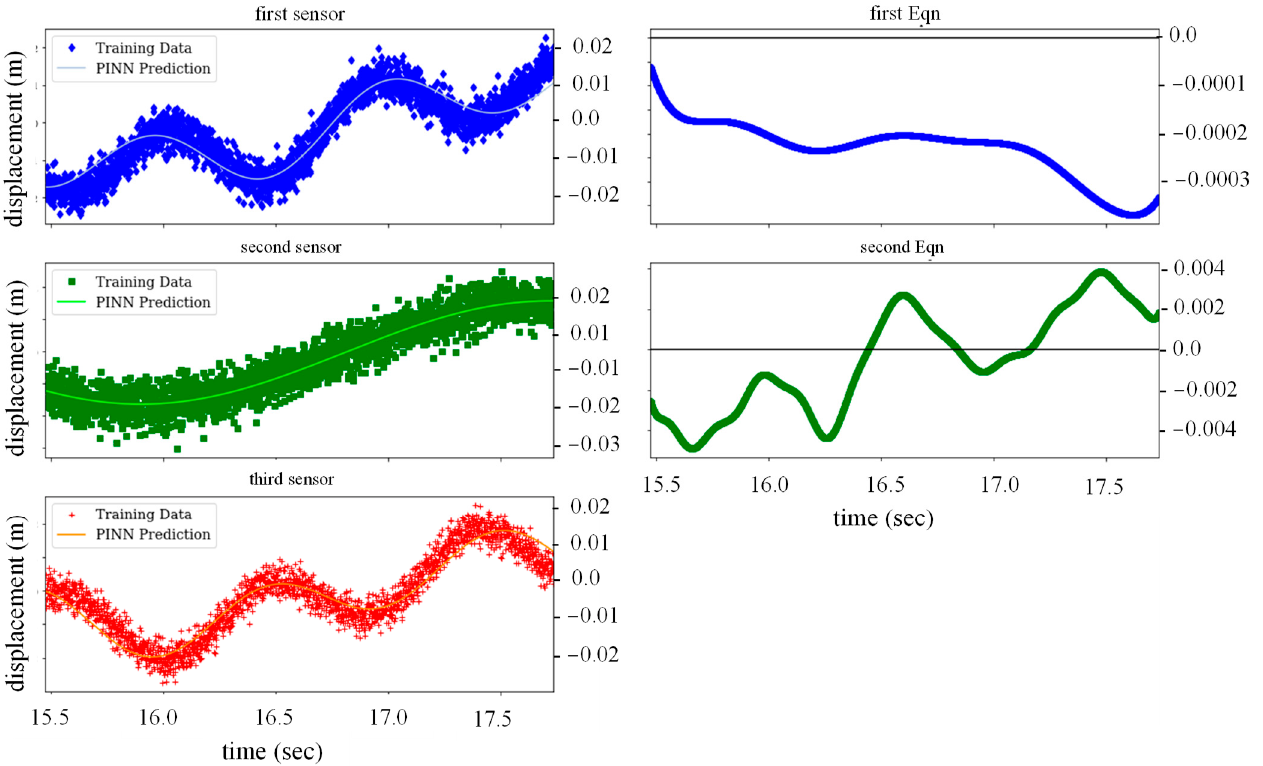
Figure 30. Parallel PINN estimations during the training period with displacement output.